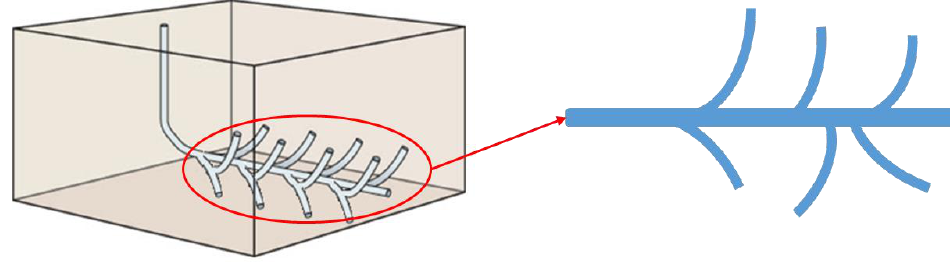
Figure 1. Fishbone Drilling Technology.